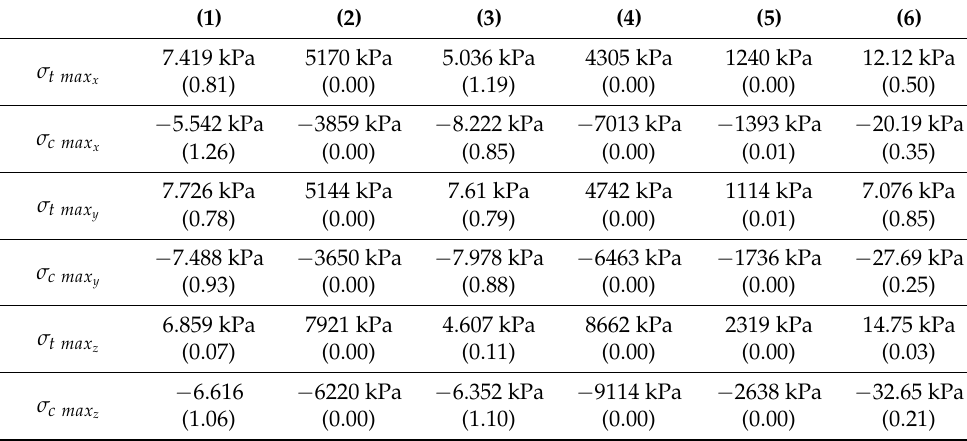
Table 5. Maximum tensile and compression stresses σ t , c max case. The safety factor 𝑆 is written in brackets.